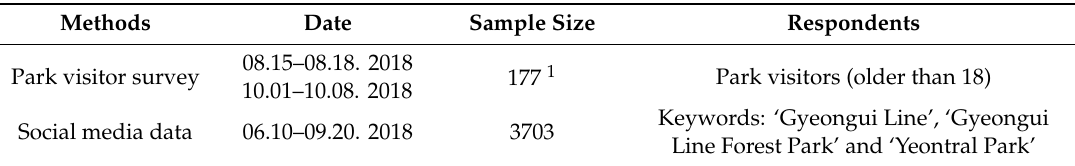
Table 1. Data collection description.